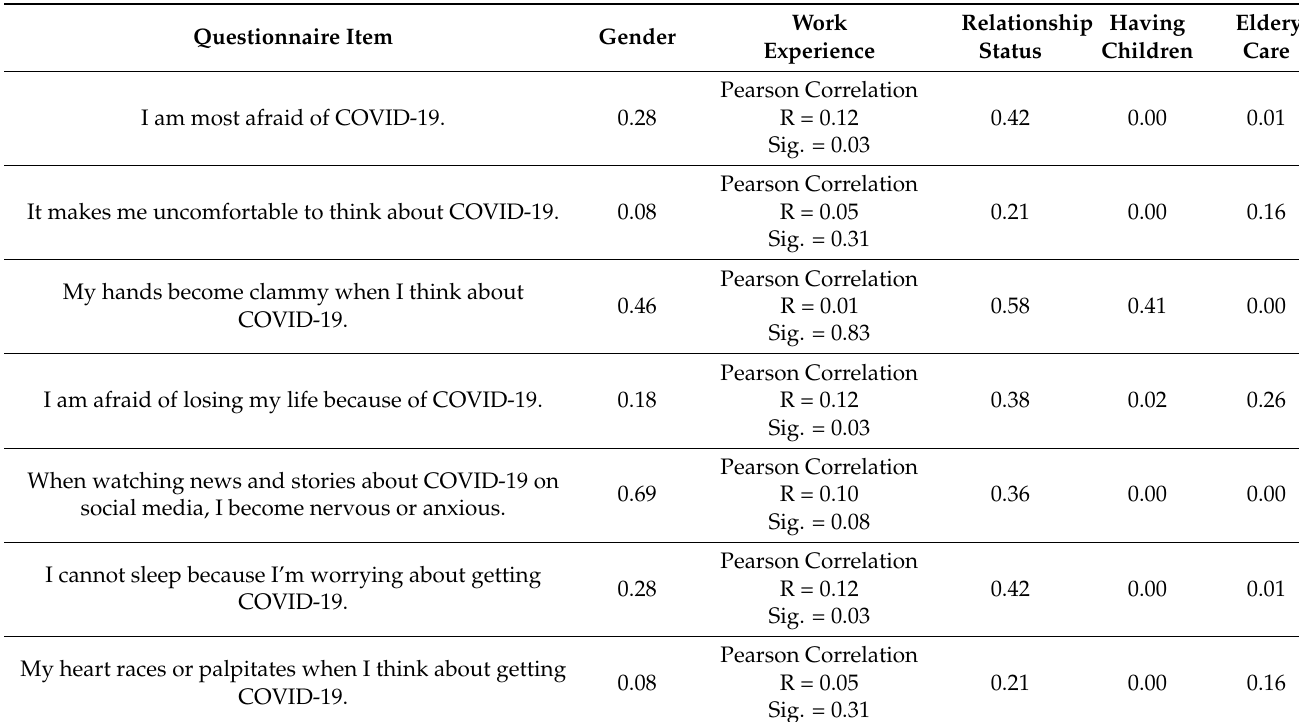
Table 4. Statistical significance of the chi-square test and values and statistical significance of Pearson’s correlation